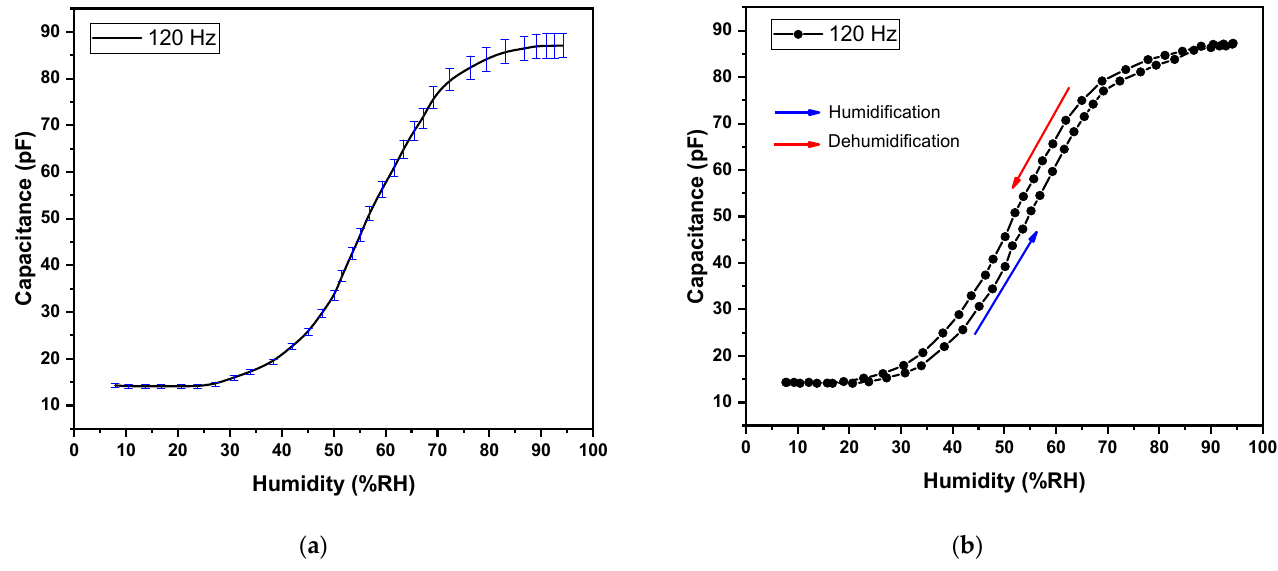
Figure 6. ( a ) Capacitance vs. relative humidity curve and ( b ) Hysteresis loop of Capacitance vs. relative humidity for Ag/F8-Cu 2 O/Ag sensor at 120 Hz.